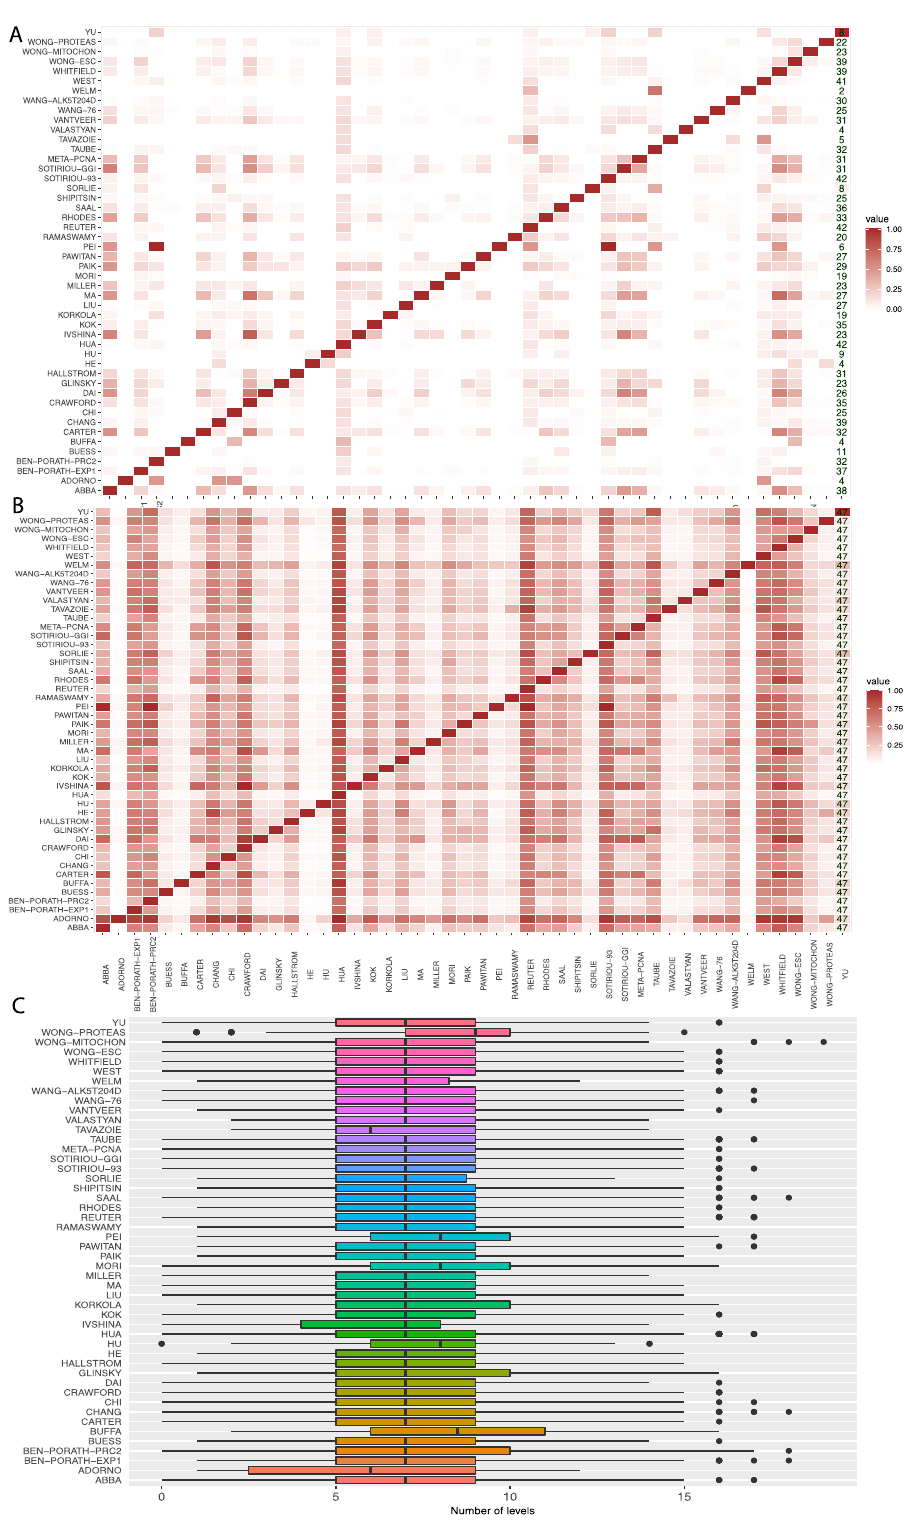
Figure 3. ( A ) Pairwise overlap of genes in BM signatures. ( B ) A: Pairwise overlap of GO-terms in BM signatures. ( C ) The distribution of GO-terms of BP hierarchy levels for each